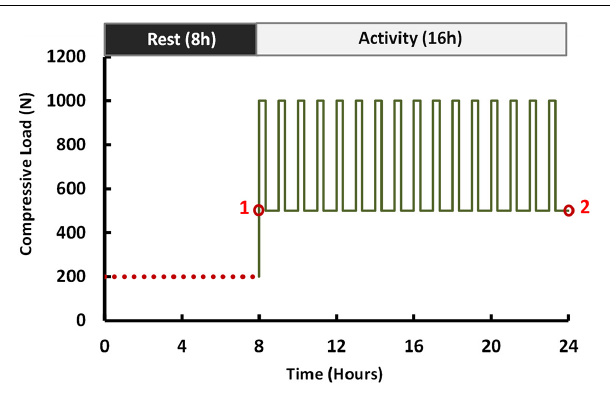
FIGURE 3 | Loading scenario of the compressive force (flexion, extension, lateral bending, and axial rotation moments of 10 N m were applied at points 1 and